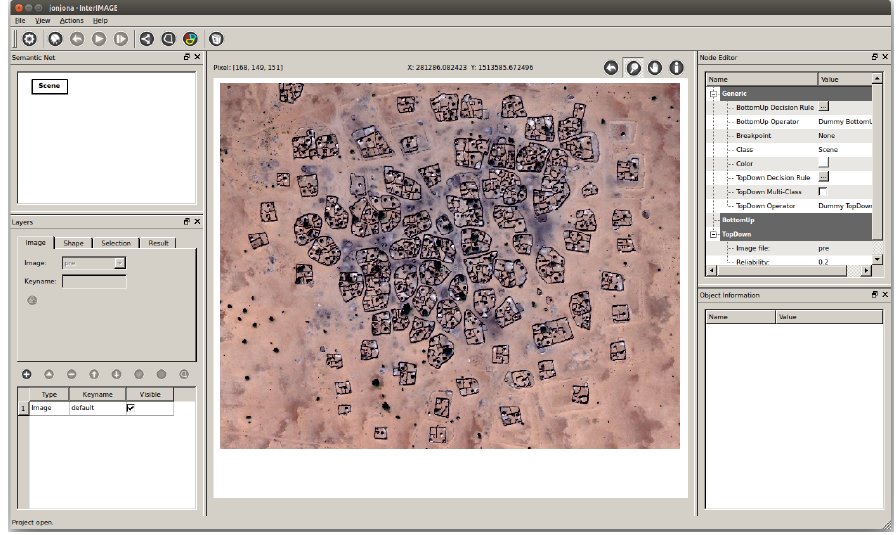
Figure 7. Screenshot of InterIMAGEUI. The software was started with a shared X server using the command xhost + && docker run -it –rm -v /tmp/.X11-unix:/tmp/.X11-unix -e DISPLAY=unix$DISPLAY -e uid=$(id -u) -e gi d=$(id -g) -v /data:/data nuest/docker-interimage:1.27 ./interimage . The command mounts the display and configures the user within the container to be the same as the executing user. It also mounts a data directory containing the workspace, of which one input image is displayed in the central area of the